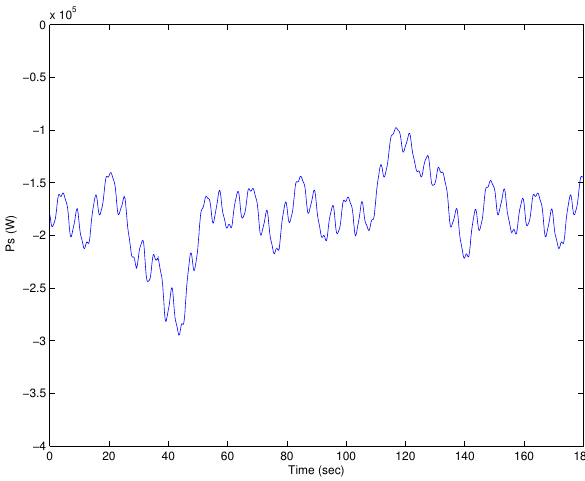
Figure 12. The active power of the stator P s versus time.